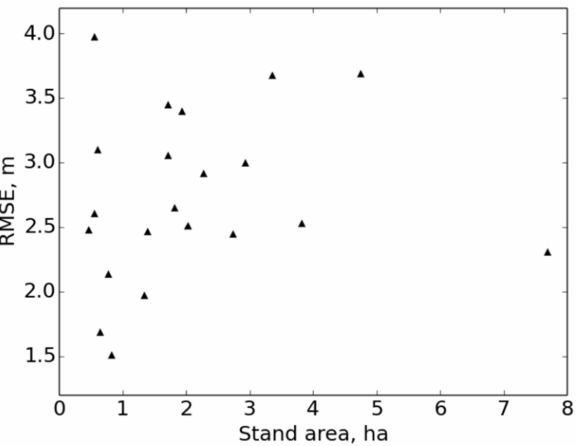
Figure 8. The RMSE of displacement distances in the strip road networks as a function of the area of the harvested stand.